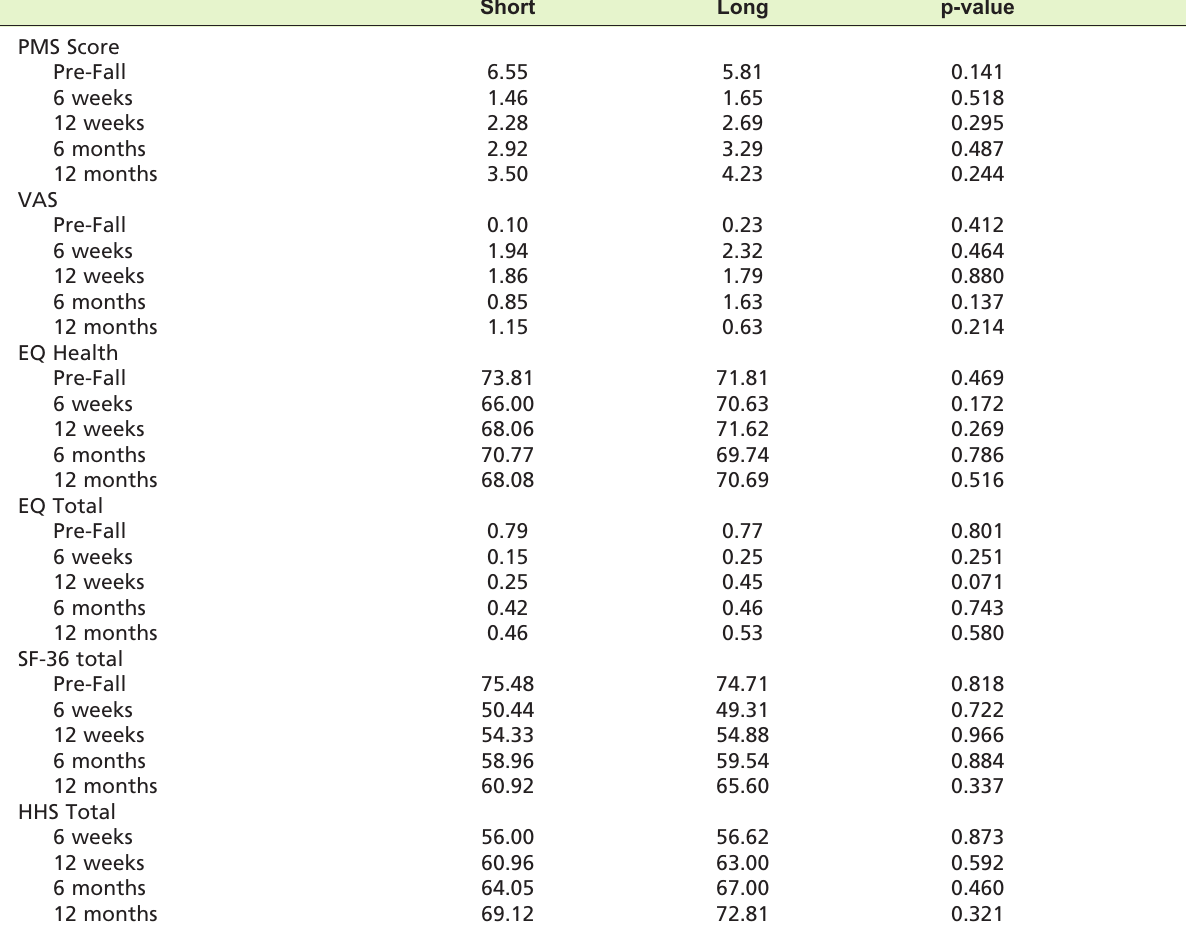
Functional Outcome Scores Table II: